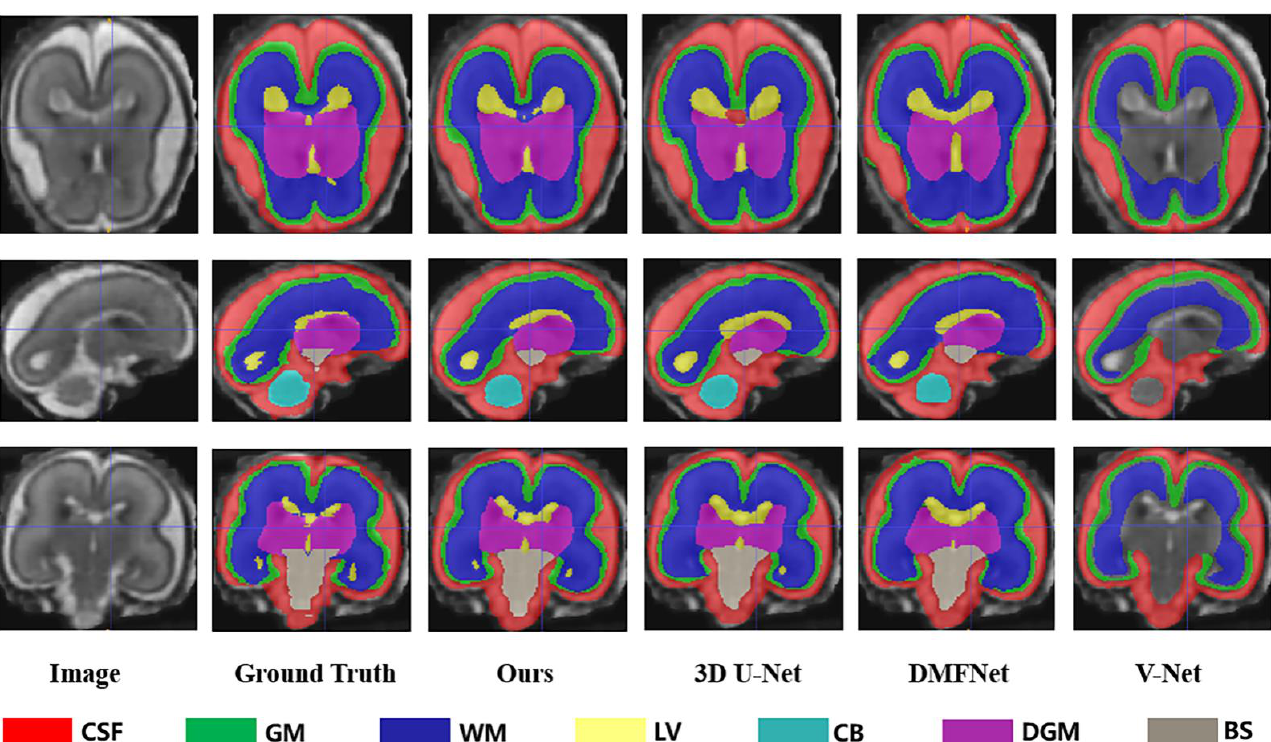
Figure 4. Segmentation results of different methods (Ours, 3DU-Net, DMFNet and V-Net) in axial, sagittal and coronal planes respectively.